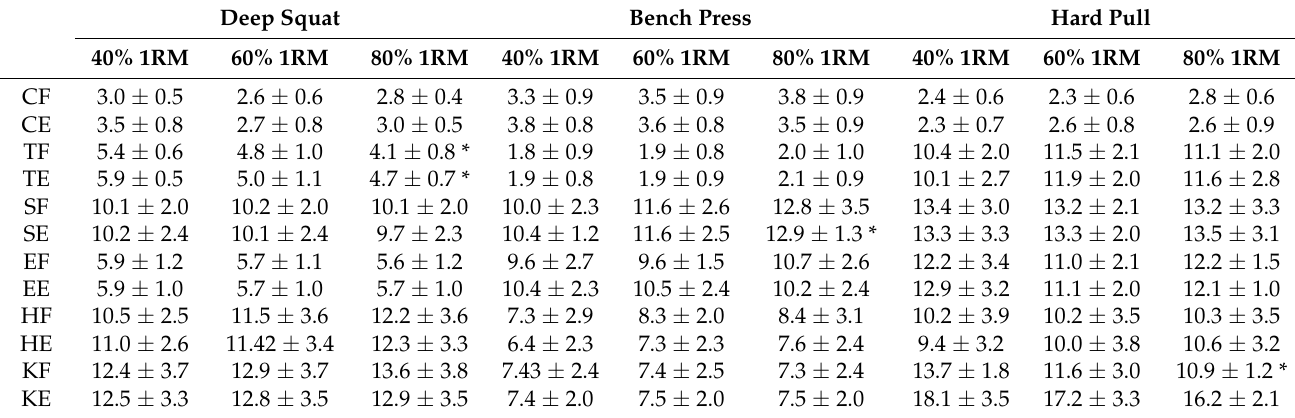
Table 2. Comparisons of the peak values of different load intensity test angular velocities ( ◦ /s). Deep Squat Bench Press Hard Pull